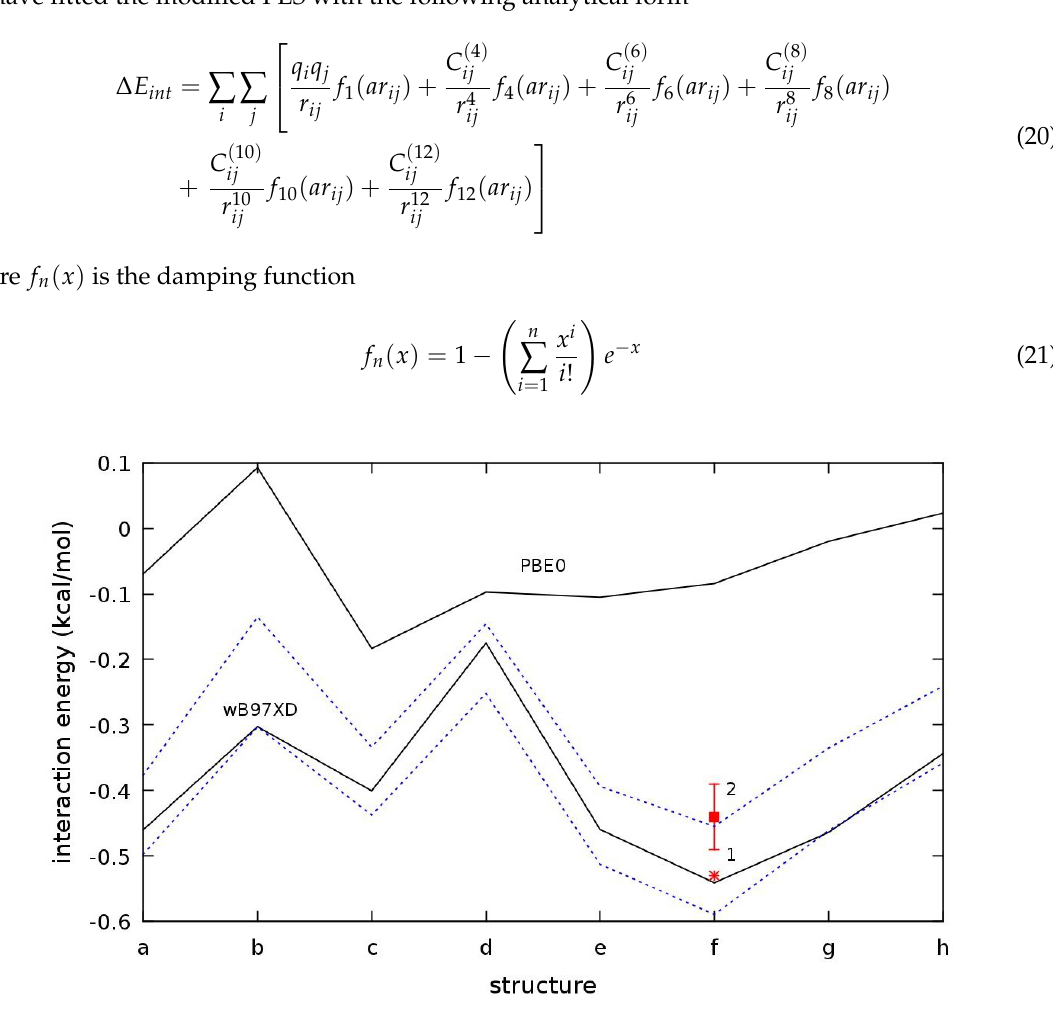
Figure 4. PBE0 and ω B97XD KS DFT interaction energies for the methane dimer structures considered in this work. Dashed lines correspond to counterpoise corrected ( upper ) and uncorrected ( lower ) MP2/aug-cc-pvTZ data plotted for comparison. Isolated points refer to the minimum energy configuration literature benchmark CCSD(T)/CBS (1) [35] and of the QMC calculation of Dubecký et al. [36]